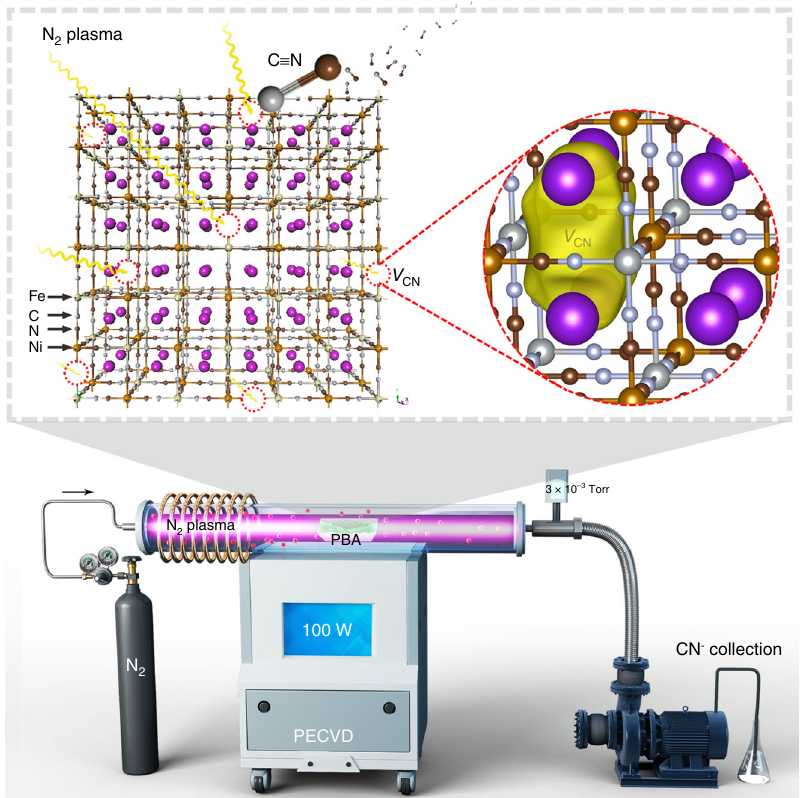
Fig. 1 Schematic illustration of the preparation of V CN -mediated Ni – Fe PBA. Top: V CN forms in Ni – Fe PBA material through N 2 plasma bombardment. Bottom: a full diagram of the N 2 plasma